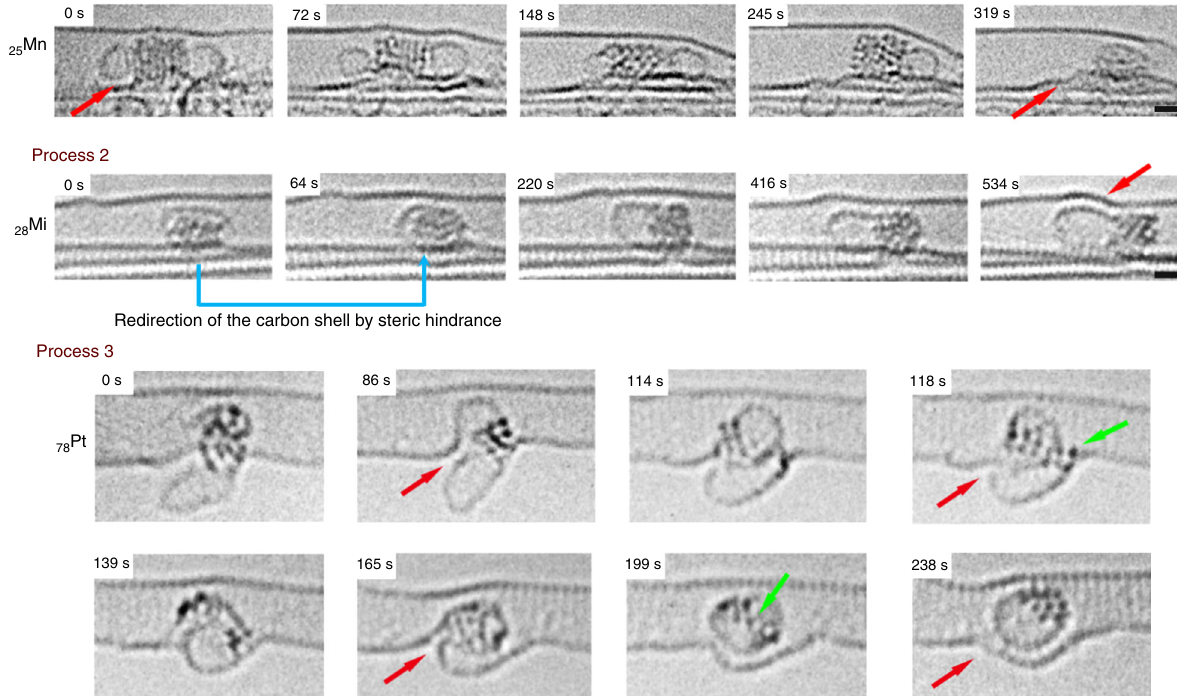
Fig. 4 Catalysis by 14 metal nanoclusters. a Representative examples of 80 keV AC-HRTEM images of the 14 transition metal nanoclusters in carbon nanotubes highlighting different examples of catalytic behaviour that are manifested as the rearrangement and formation of a variety of carbon nanostructures. b Time-series AC-HRTEM images illustrating three fundamental types of metal nanocluster activities. ‘ Process 1 ′ : a Mn nanocluster promotes incorporation of the native carbon shell into the nanotube sidewall, which causes the lower part of the NT to warp, as indicated by the red arrows. ‘ Process 2 ′ : a Ni nanocluster abstracts carbon atoms from a point of contact with the host NT and promotes the formation of a new carbon structure. The direction in which the carbon shell grows is dictated by steric hindrance imposed by the host nanotube (indicated with blue arrows). The loss of carbon atoms from the host NTs leads to structural deformation (indicated with red arrow). ‘ Process 3 ′ (a combination of ‘ Process 1 ′ and ‘ Process 2 ′ ): a Pt nanocluster abstracts carbon atoms from the host NT and restructures them into a carbon shell and simultaneously promotes incorporation of the native carbon shell into the host NT (areas of new carbon structure formation and sealing of a loop-and-hole structure are indicated by red arrows, individual Pt atoms dissociated from the nanocluster are indicated by green arrows). The scale bar is 1